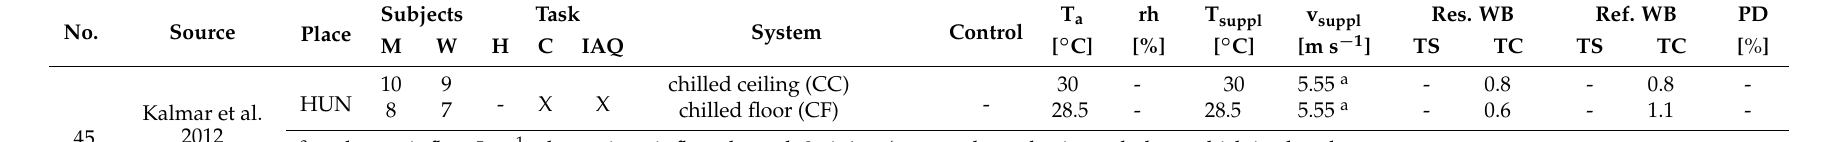
Table A6. Personal ventilation (possible preconditioning of the supplied air) and evaporative